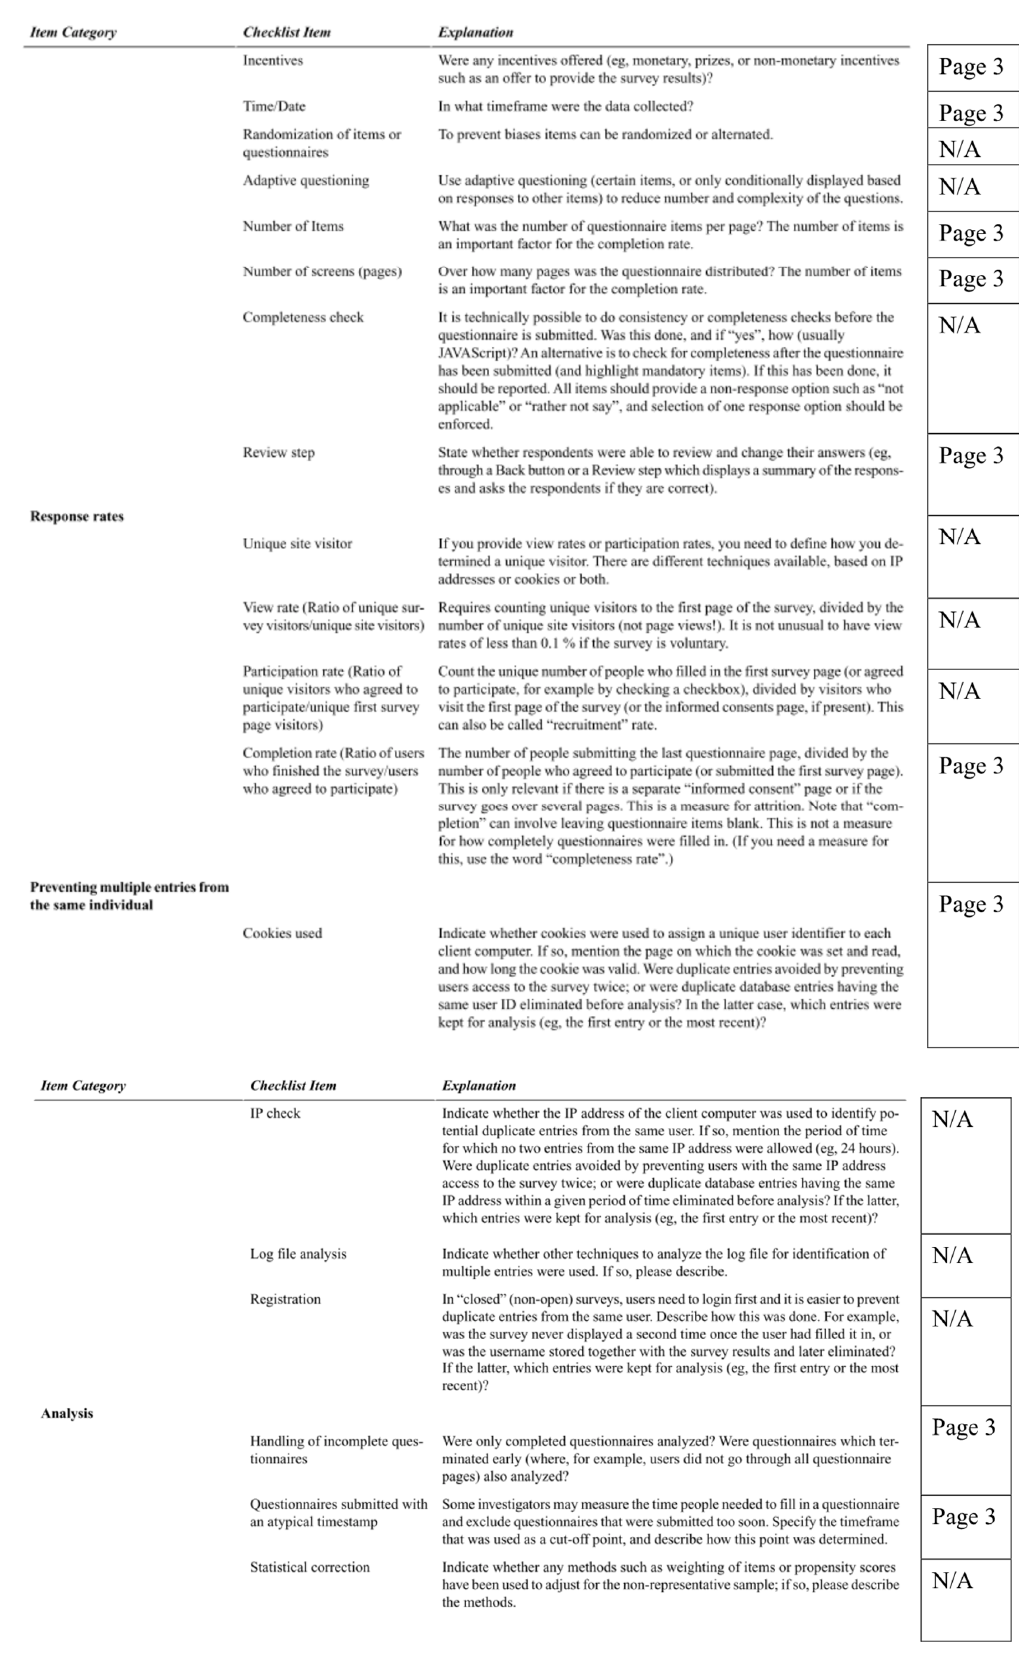
Figure A1. Cherries